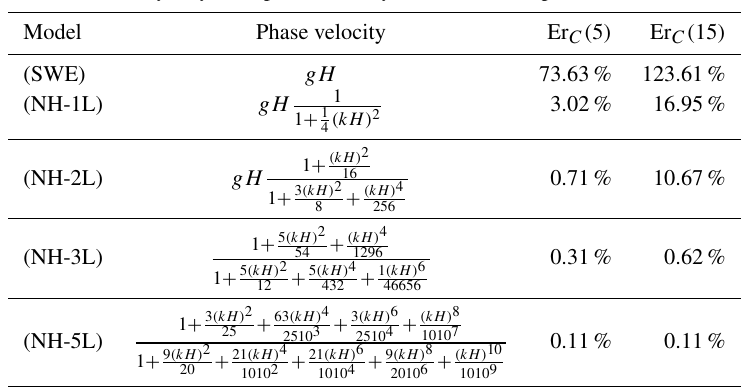
Table 1. Phase velocity expressions and maximum of the relative error Er C (s) compared with Airy’s theory for different ranges of kH ∈ [ 0 ,s ] for the non-linear hydrostatic shallow-water system (SWE) and the Multilayer-HySEA (non-hydrostatic) system with j ≥ 1 layers